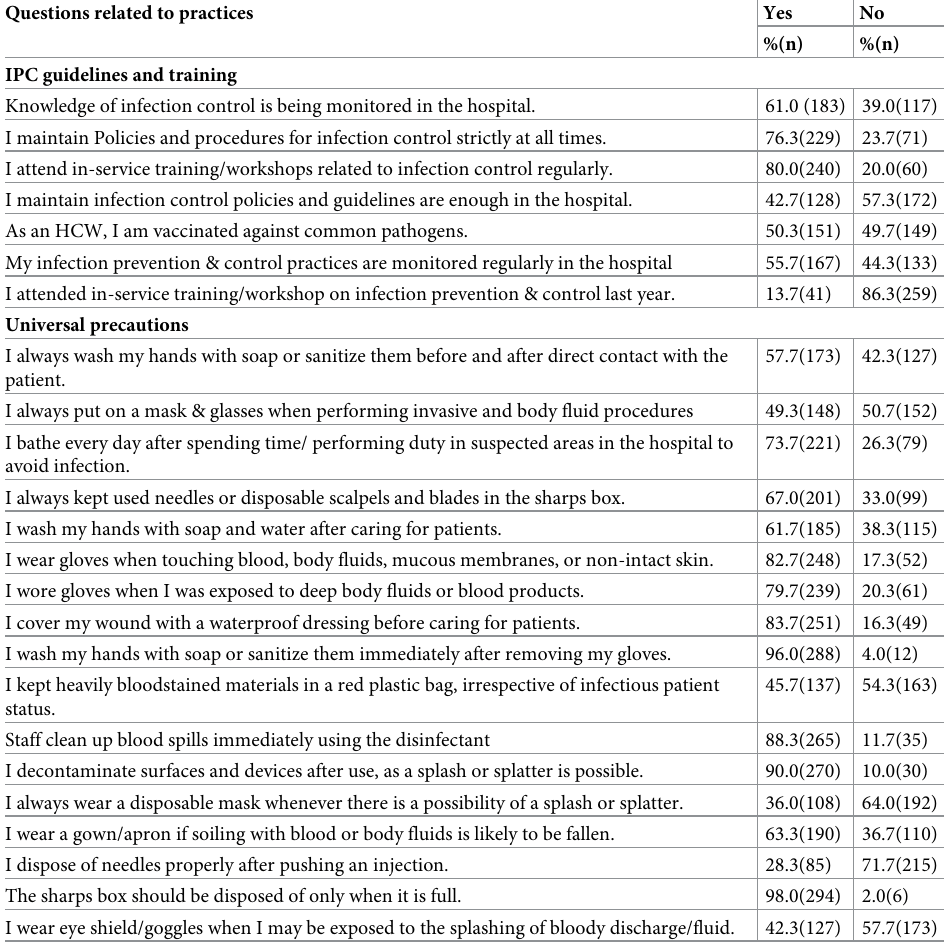
Table 4. Practice of the nurses regarding infection prevention and control, universal precautions, disinfection, sterilization (N = 300). Questions related to